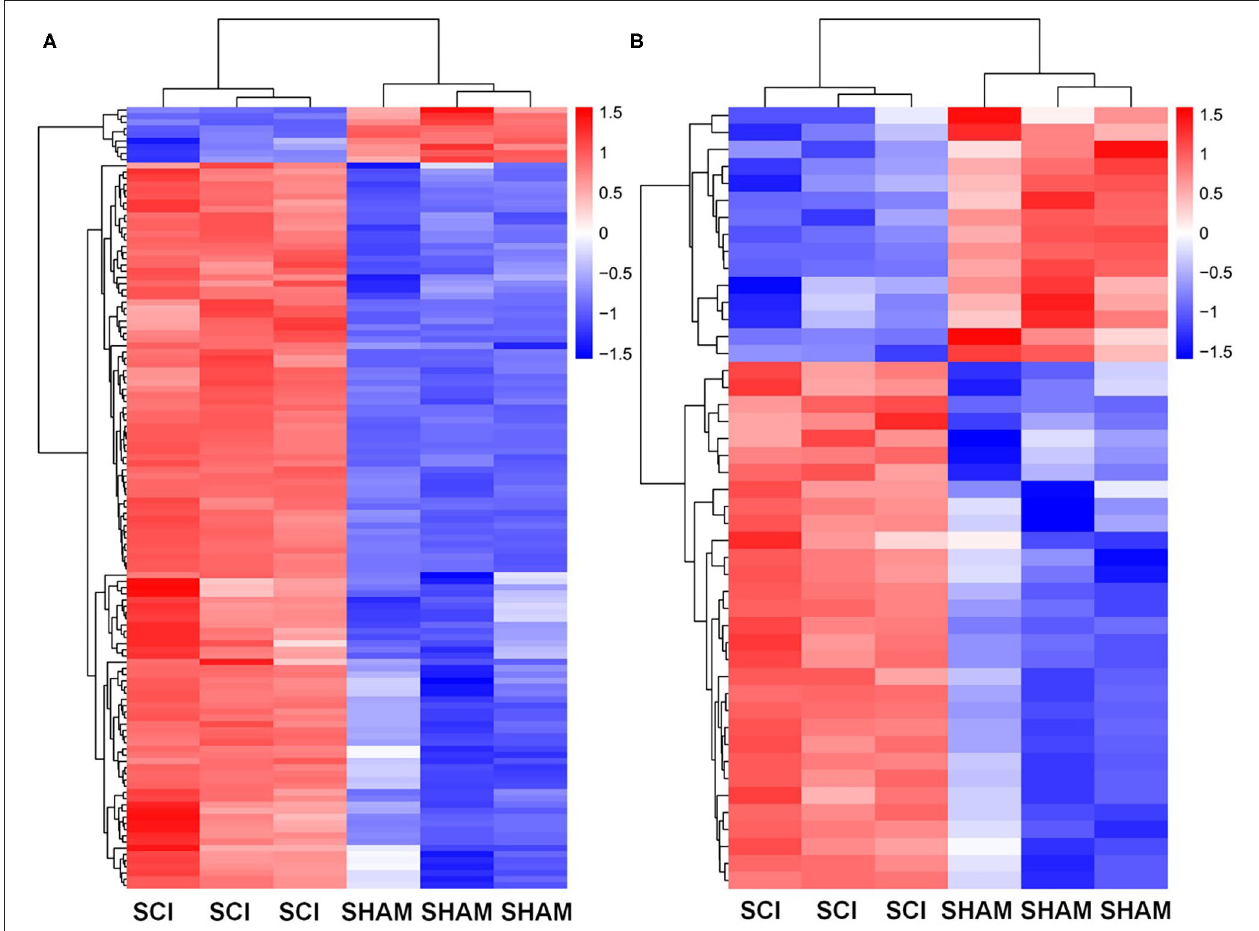
FIGURE 7 | KEGG analysis for genes and circRNAs related to vascular endothelial proliferation, migration, and angiogenesis express profiles. (A) Heat map of KEGG analysis mRNAs ( > 2-fold change, p < 0.01) enriched for pathways associated with vascular endothelial proliferation, migration, and angiogenesis. (B) The heat map of circRNAs ( > 2-fold change, p < 0.01) based on ceRNA analysis of KEGG mRNA